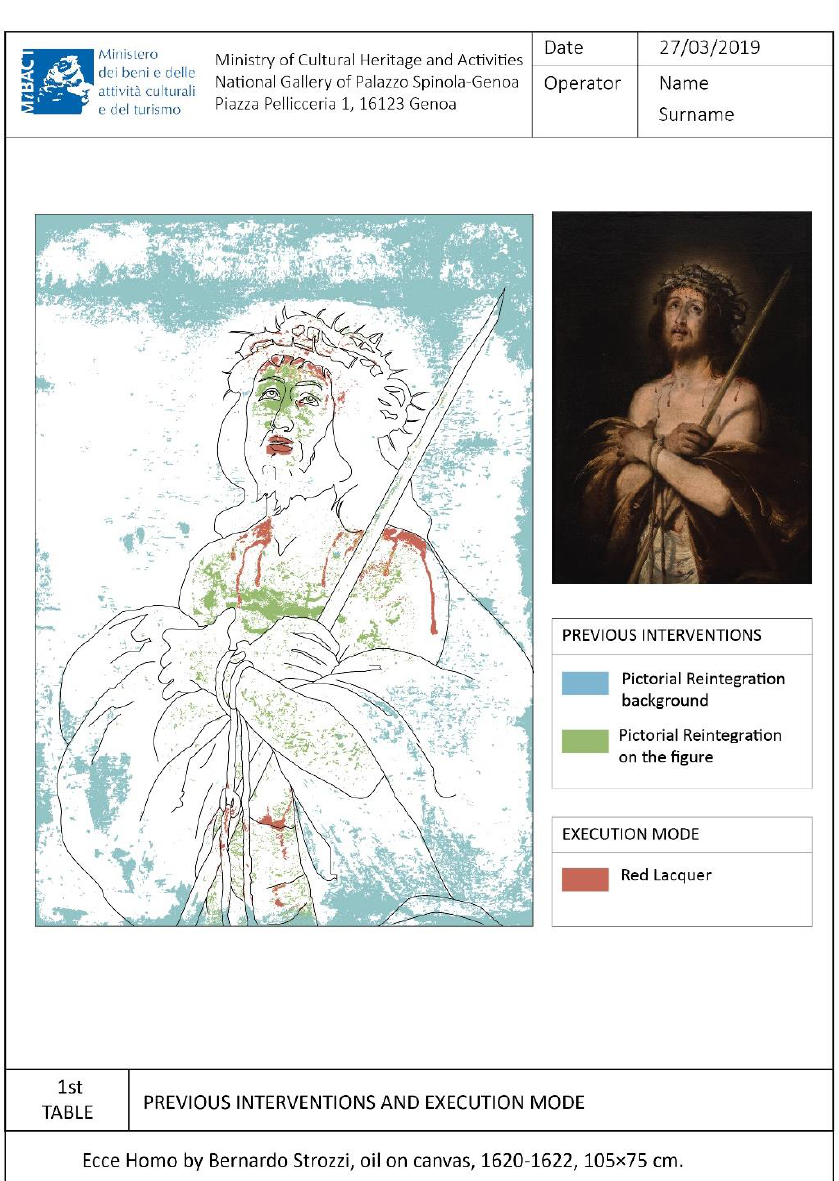
Figure 5. Thematic map-specific colors are assigned to the ROIs (statistical data are omit- ted).